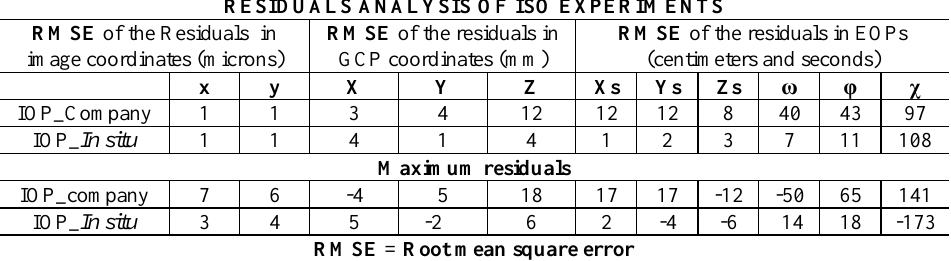
Table 7. Main results of the residuals analysis of the ISO experiment of the second block with control points